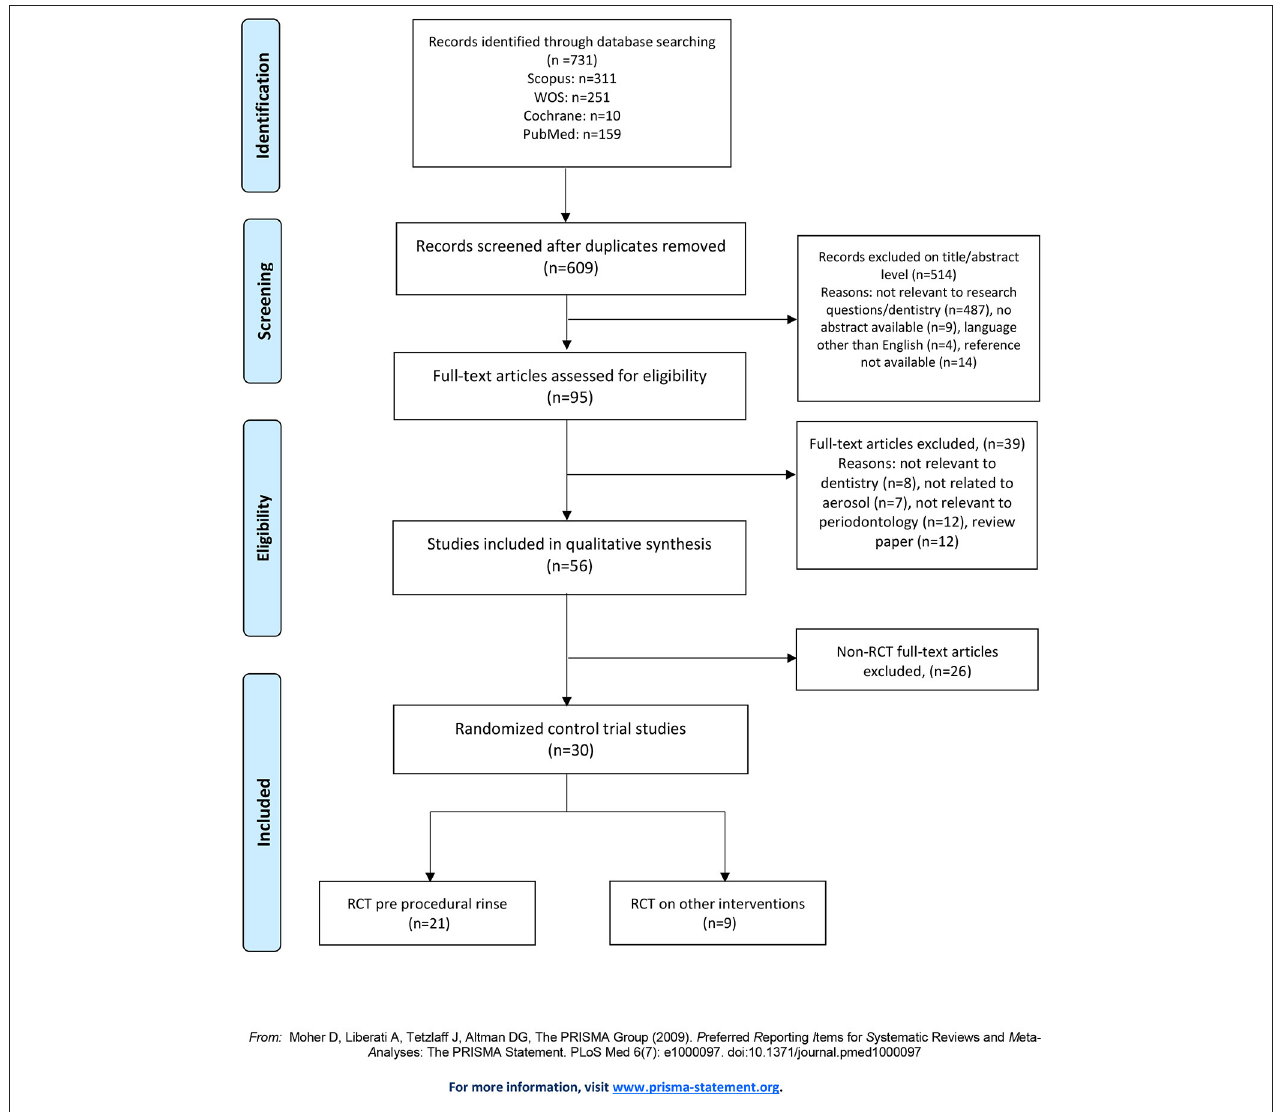
FIGURE 1 | Summary of the selection process for systematic